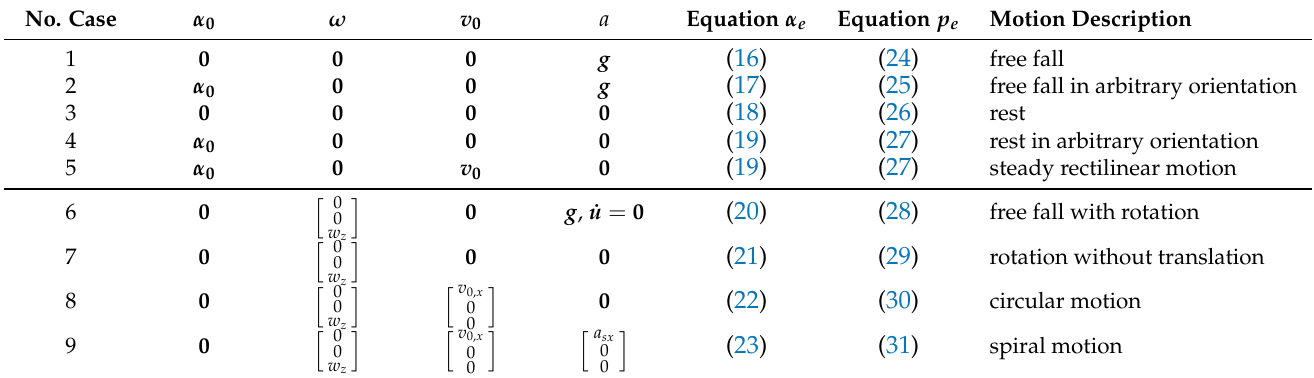
Table 1. List of considered manoeuvres.